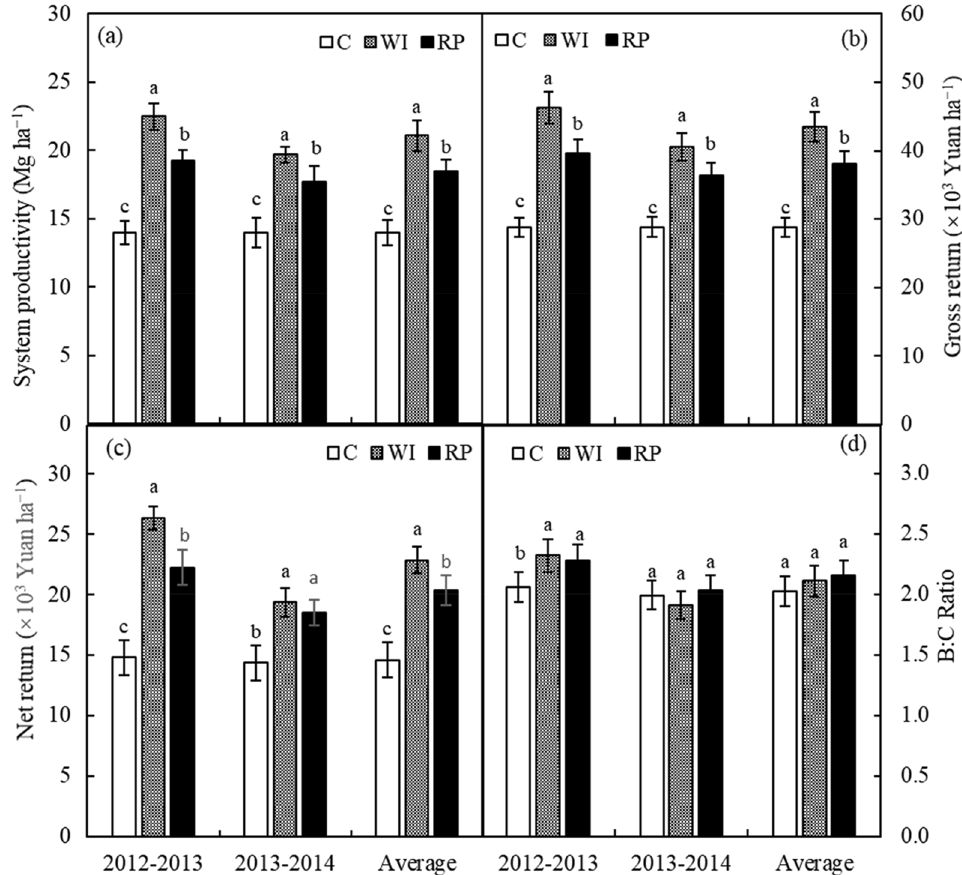
Figure 2. Effect of different planting strategies on system productivity ( a ), gross return ( b ), net return ( c ) and benefit: cost ratio (B:C ratio), ( d ) of wheat–maize cropping system.